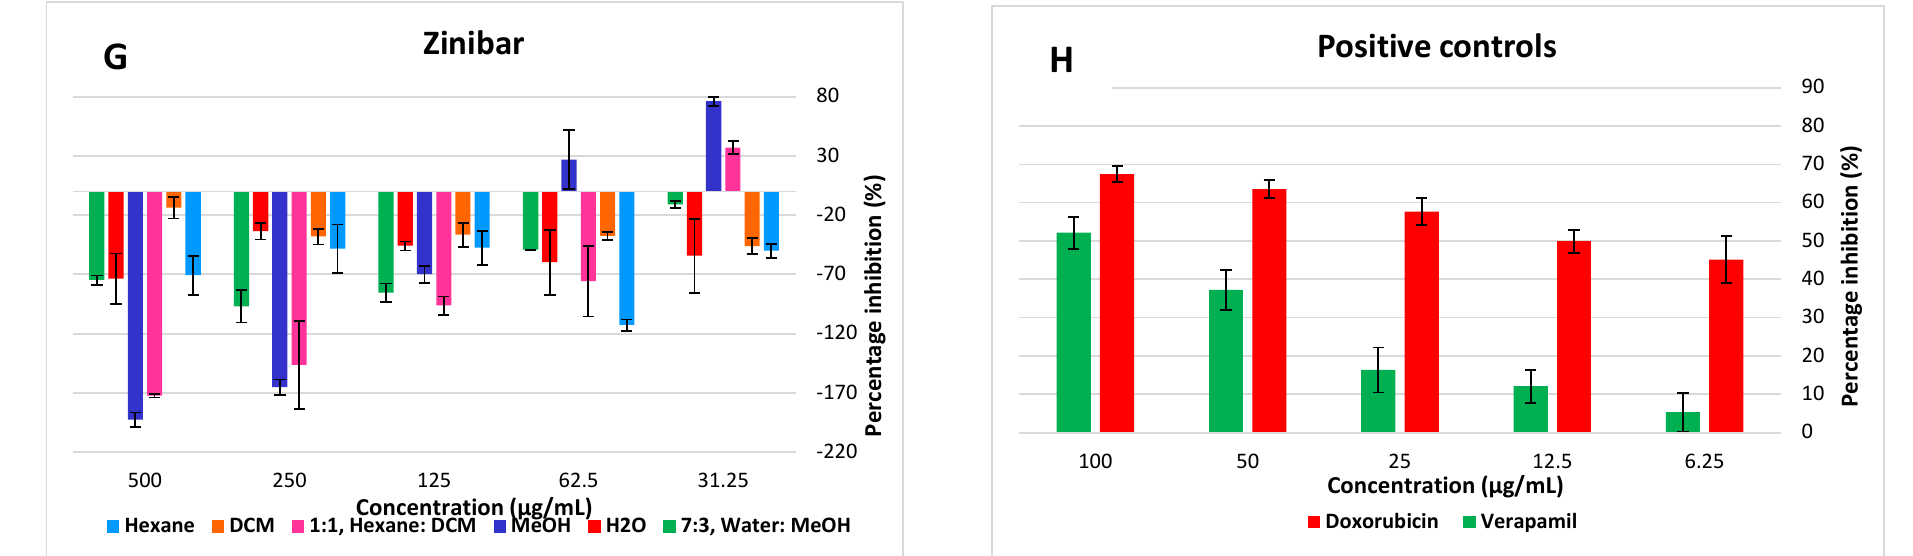
Figure 4. Cytotoxicity and cell proliferation on normal human Chang Liver cells over 24 h exposure of tested indigenous tea plants with trade names (( A ) Haw; ( B ) Gancair; ( C ) Moologa; ( D ) Mosukujane; ( E ) Resurrection bush; ( F ) Tinar; ( G ) Zinibar. ( H ) Positive controls).